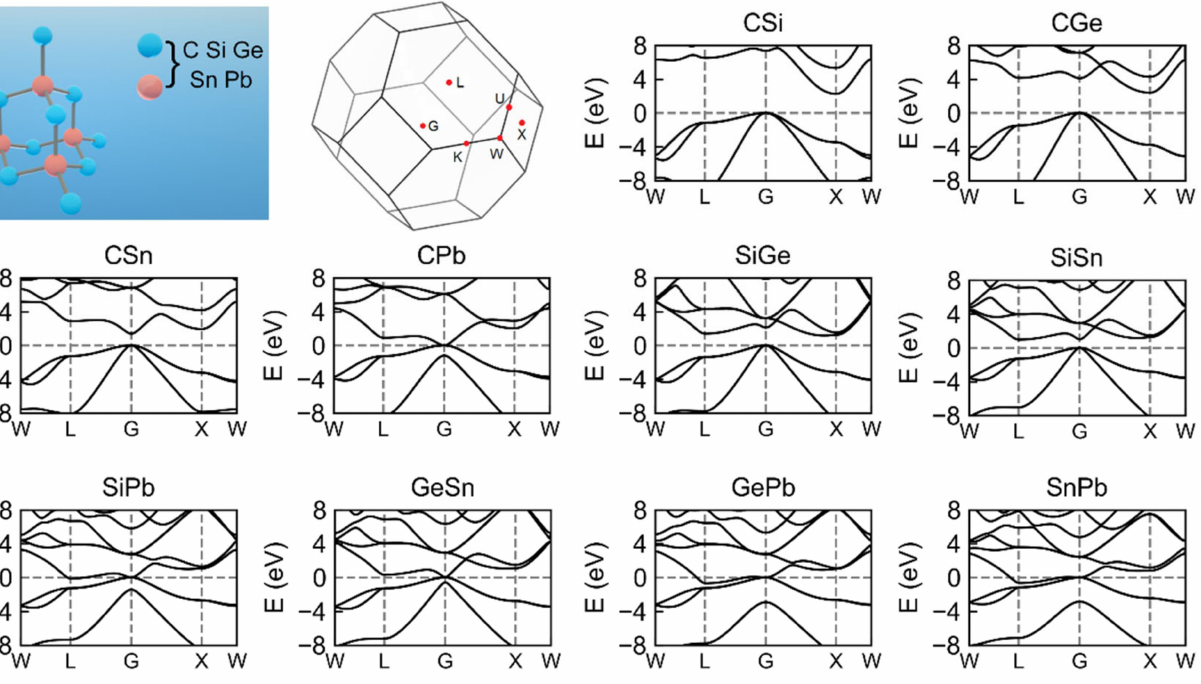
Figure 1. The crystal structure diagram, high symmetry points in the first Brillouin zone, and band structures of group 14 alloys from HSE06